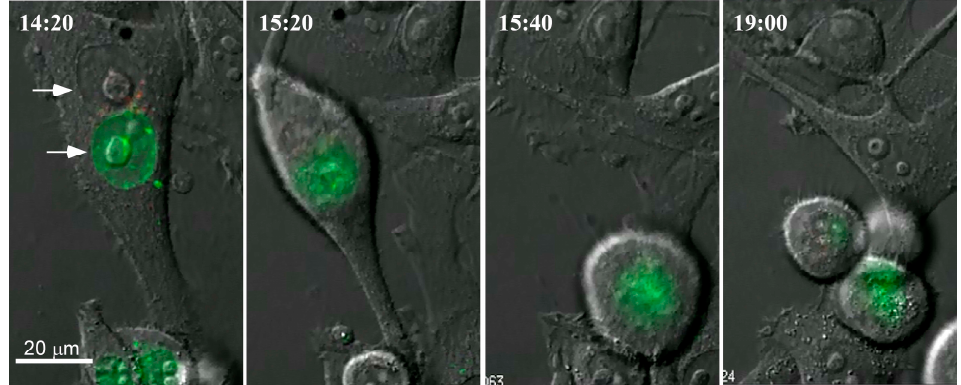
Figure 1. Mechanism of formation of hybrid mononuclear cells after cell fusion. HeLa cells were differentially labeled with Cyanine 5 (Cy5)-dUTP) or cyanine 3 (Cy3)-dUTP and then fused with polyethylene glycol. The first image obtained 14 h and 40 min after exposure to PEG shows a cell that has undergone fusion, the arrows denoting nuclei from parental cells. The cell contains distinct nuclei from two parental cells. At 15 h 20 min, the cell is undergoing mitosis. At 15 h 40 min, the nuclear envelopes of the parental cells have disintegrated and the labeled DNA of parental cells is admixed. At 19:00, mitosis is complete, cytokinesis is nearly complete and labeled DNA from both cells originally fused is seen in both daughter cells. This figure shows that intermixing of parental DNA occurs during but not before mitosis.